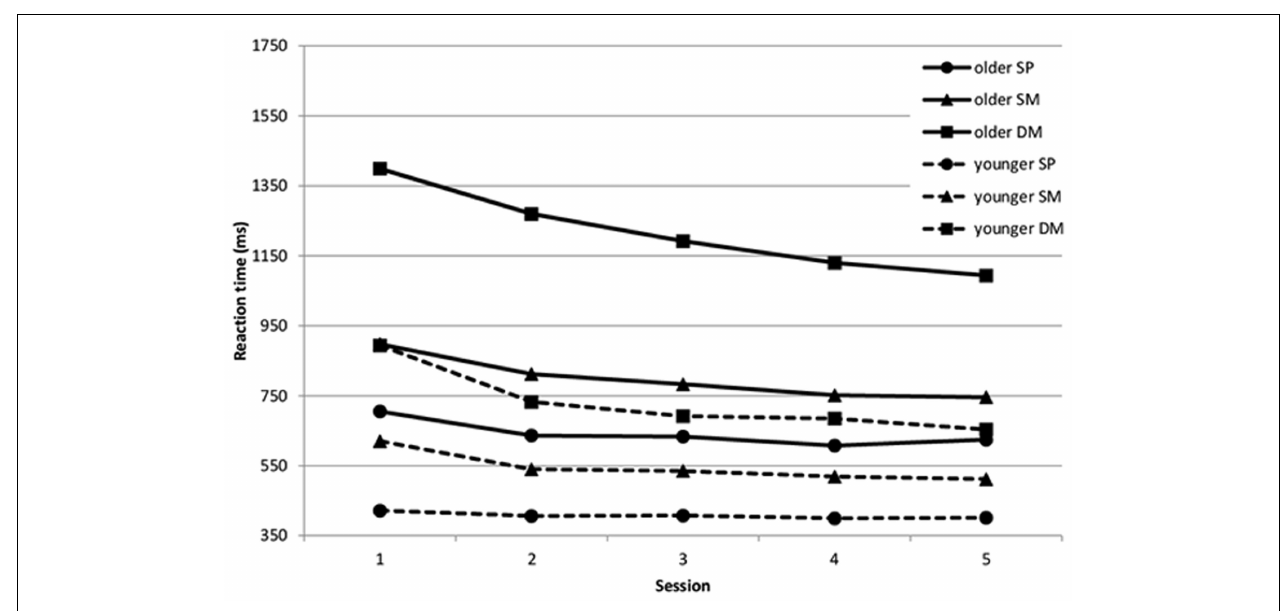
FIGURE 1 | Mean reaction time (ms) for older and younger adults in the three trial types [single pure ( SP), single mixed ( SM), and dual mixed ( DM)], as a function training sessions.